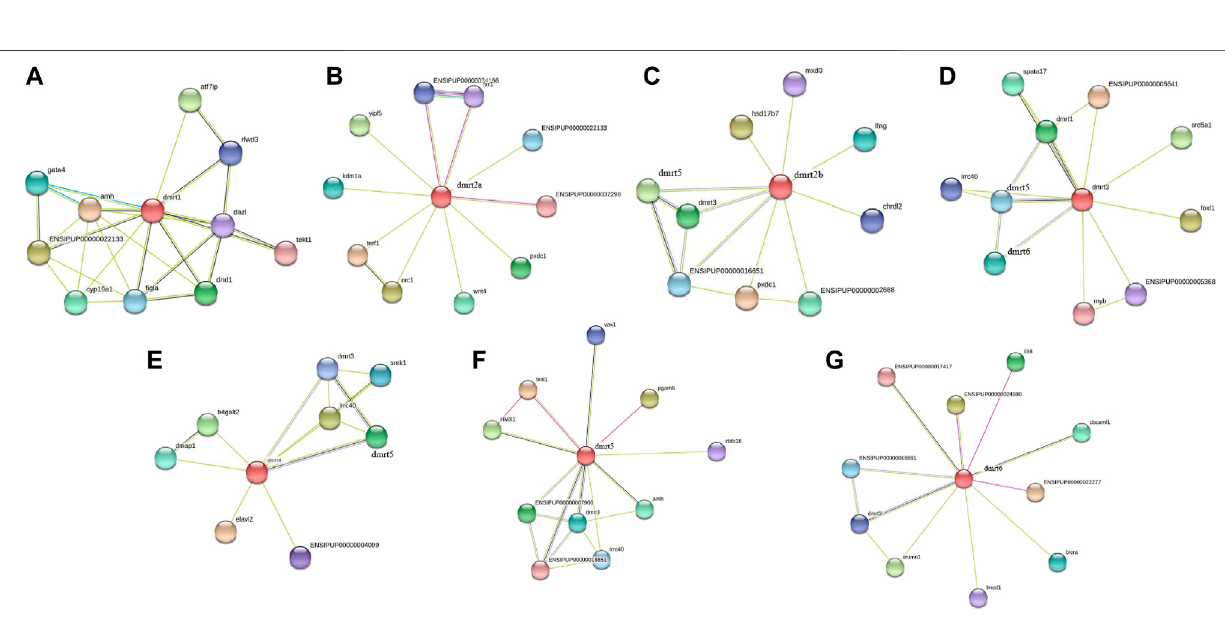
Frontiers in Genetics |